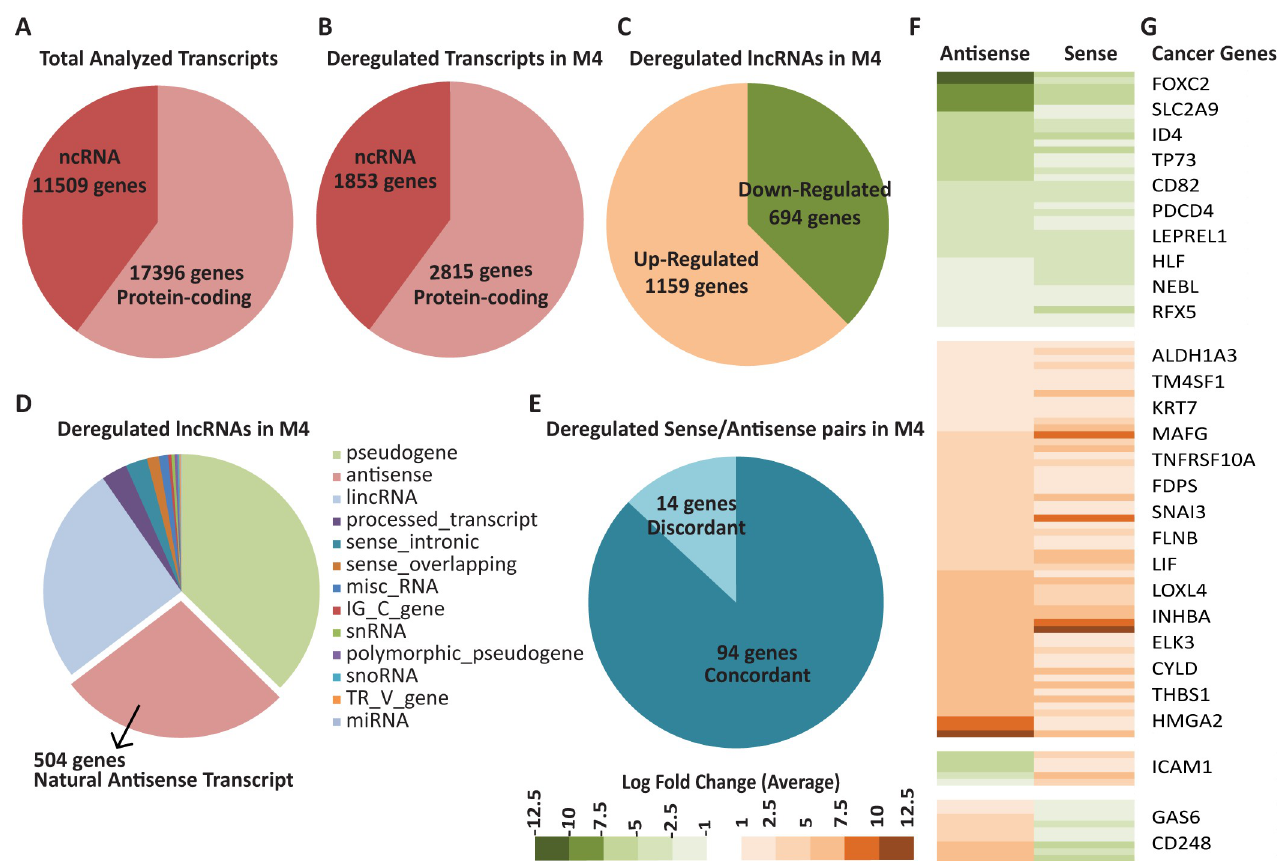
Fig 1. Long noncoding RNAs, including NATs show differential expression during breast cancer progression. A) Total number of genes analyzed in M1 and M4 cells. B) Number of deregulated ncRNA and protein-coding RNA genes in M4 cells compared to M1 cells. C) Number of deregulated lncRNA genes in M4 compared to M1 cells. D) Different classes of aberrantly expressed lncRNA genes in M4 compared to M1 cells. E) Number of sense/antisense pairs that show concordant or discordant pattern of expression in M4 compared to M1 cells. F) Heatmap representing deregulated sense/antisense pairs in M4 compared to M1. G) Representative cancer-associated protein coding genes in the NAT/protein-coding gene pairs from the heatmap (Fig 1F). Please see S6 Table for the details of NAT/protein-coding gene pairs.